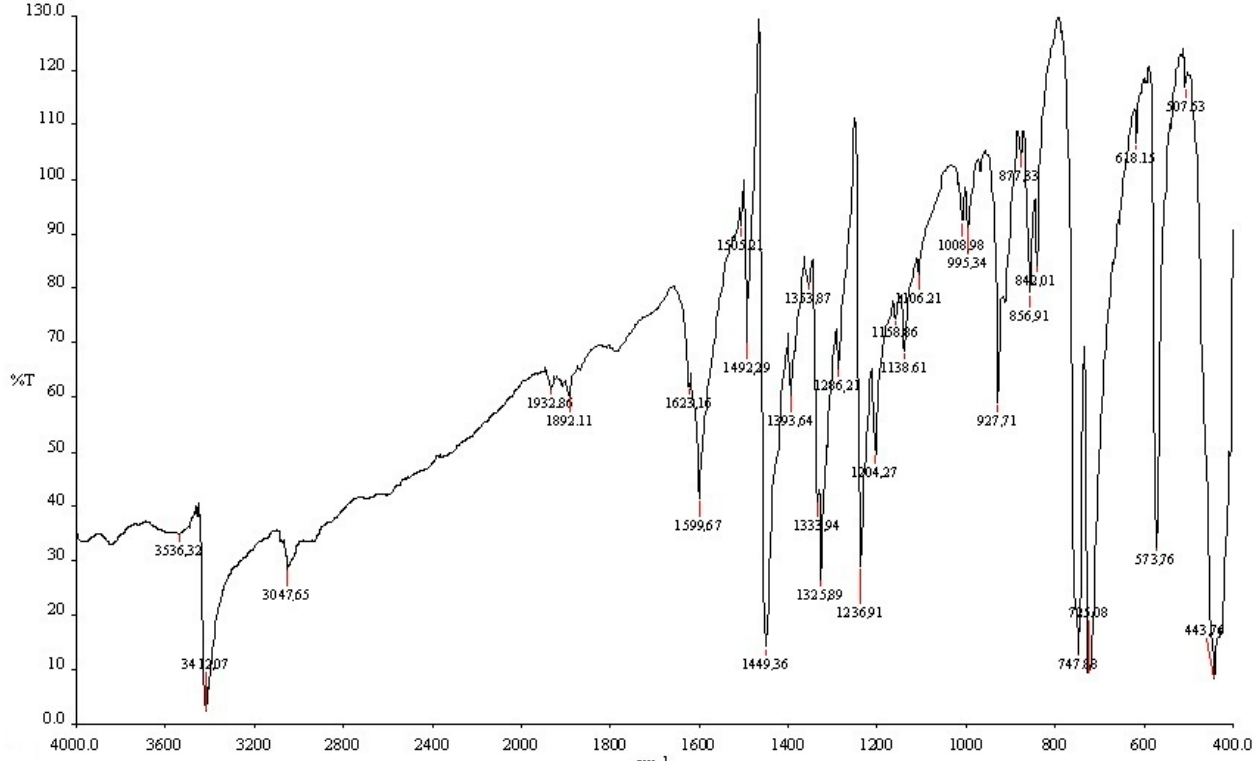
Figure 3. FT–IR spectrum of polycarbazole prepared under the best conditions (acetone, FeCl 3 , 3 h), under an electric field (12 KV/m).